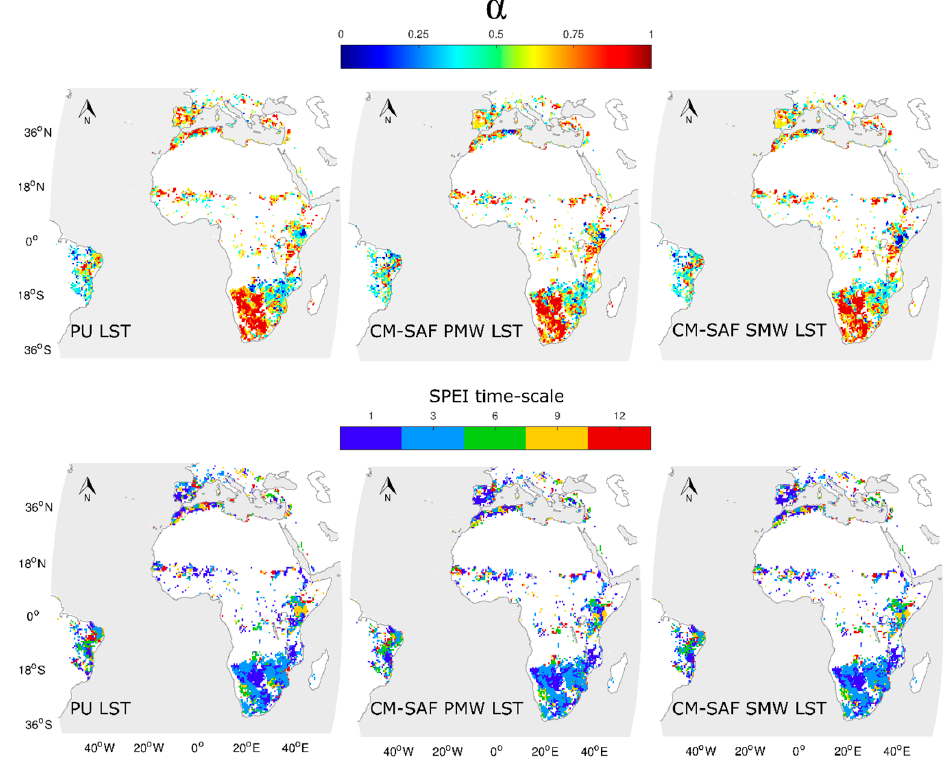
Figure 1. Parameter α ( top ) estimated by iterative maximization of Vegetation Health Index (VHI) and Standardized Precipitation-Evapotranspiration Index (SPEI), and respective SPEI time-scale ( bottom ) for which VHI and SPEI have the largest correlation, using Thermal Condition Index (TCI) computed with Princeton University Land Surface Temperature (PU LST) ( left ), Satellite Application Facility on Climate Monitoring (CM-SAF) Physical Mono-Window (PMW) LST ( middle ), and CM-SAF Statistical Mono-Window (SMW) LST ( right